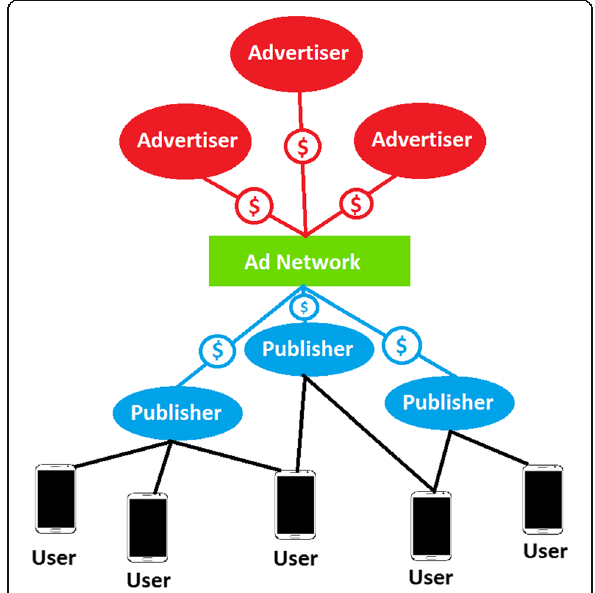
Fig. 1 Mobile advertising main